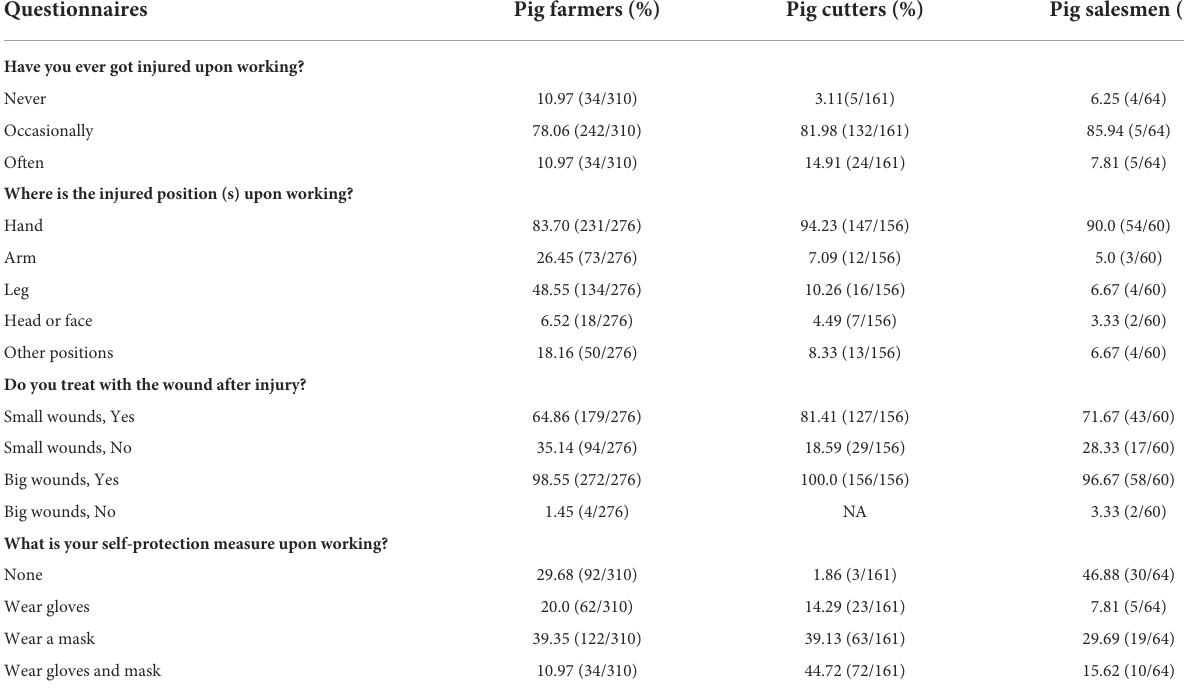
TABLE 1 Injury and self-protection upon working among pig-related practitioners.